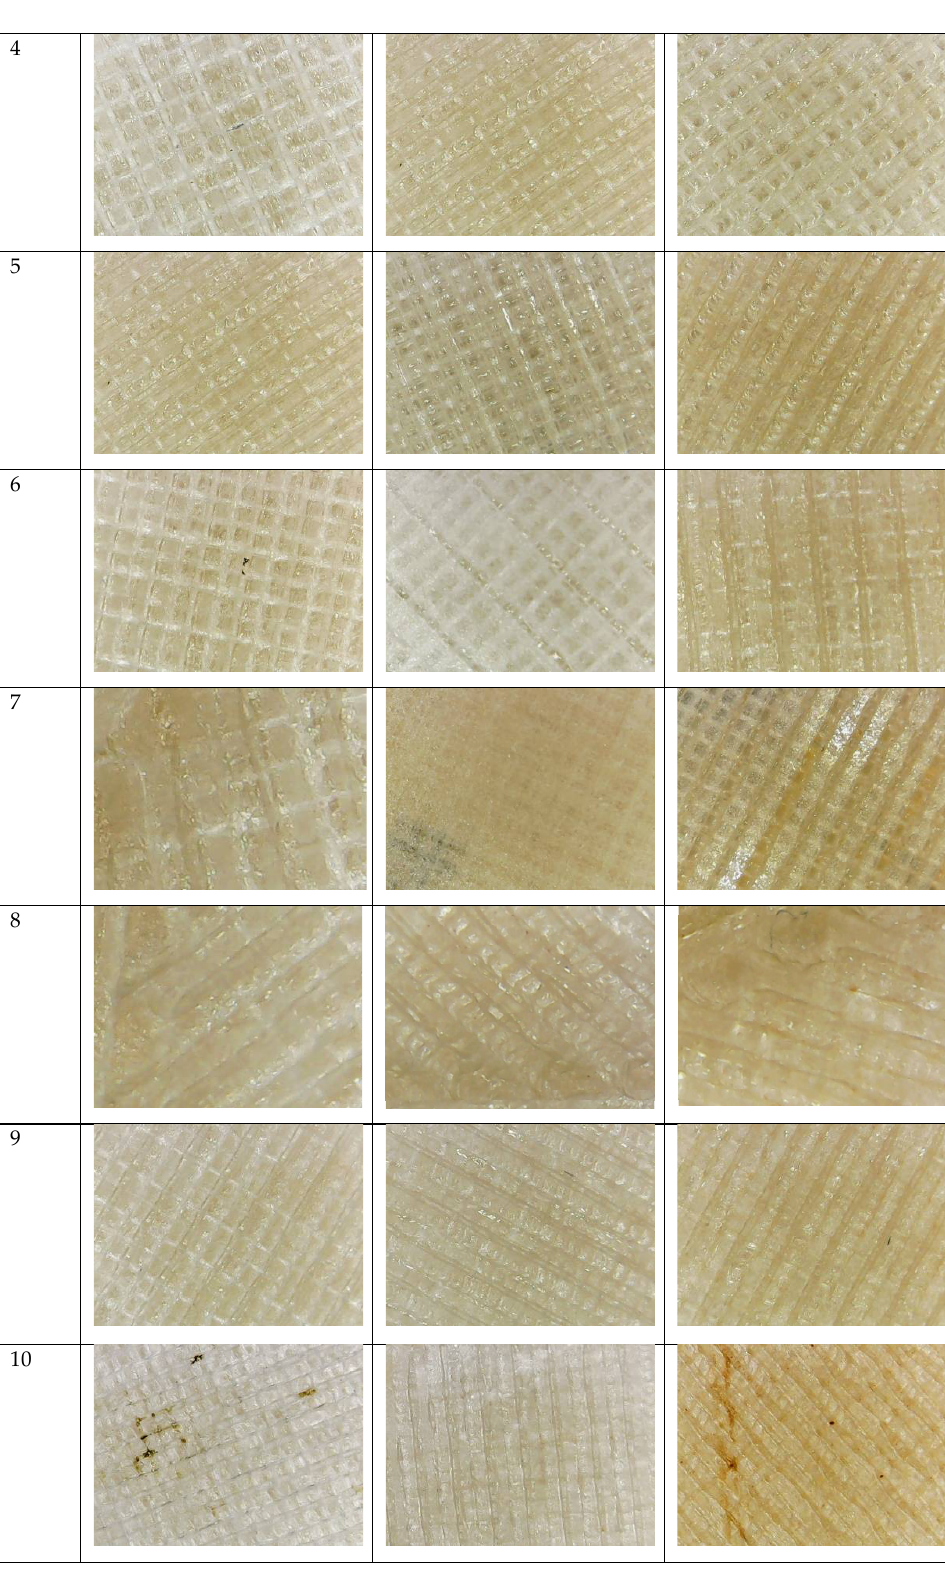
Figure A2. Degradation of PLA.